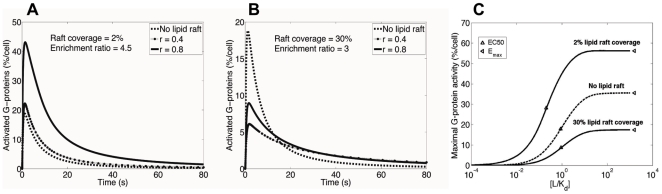
Simulation results for G-protein activation as a function of time at (A) 2% and (B) 30% raft coverage for changing values of r, the relative G-protein density in lipid rafts, (C) Simulation results for maximal G-protein activity as a function of scaled ligand concentration for different values of raft coverage.Lines marked “no lipid raft” show the predicted level of G-protein activation in the absence of lipid rafts assuming random distribution of G-proteins on the cell membrane. Although G-protein signaling is attenuated at 30% raft coverage, the rate of termination of the response is smaller compared with no lipid raft condition. This occurs due to reduced rate of (Gβγ-dependent) diffusion-limited phosphorylation (and thus desensitization) of receptors. Magnitudes of the commonly measured pharmacological parameters maximal effect, Emax, and half maximal effective concentration, EC50, are marked in (C). Parameter values are as listed in Table 1 with khyd = 10 s−1 and [L] = Kd in (A) and (B).